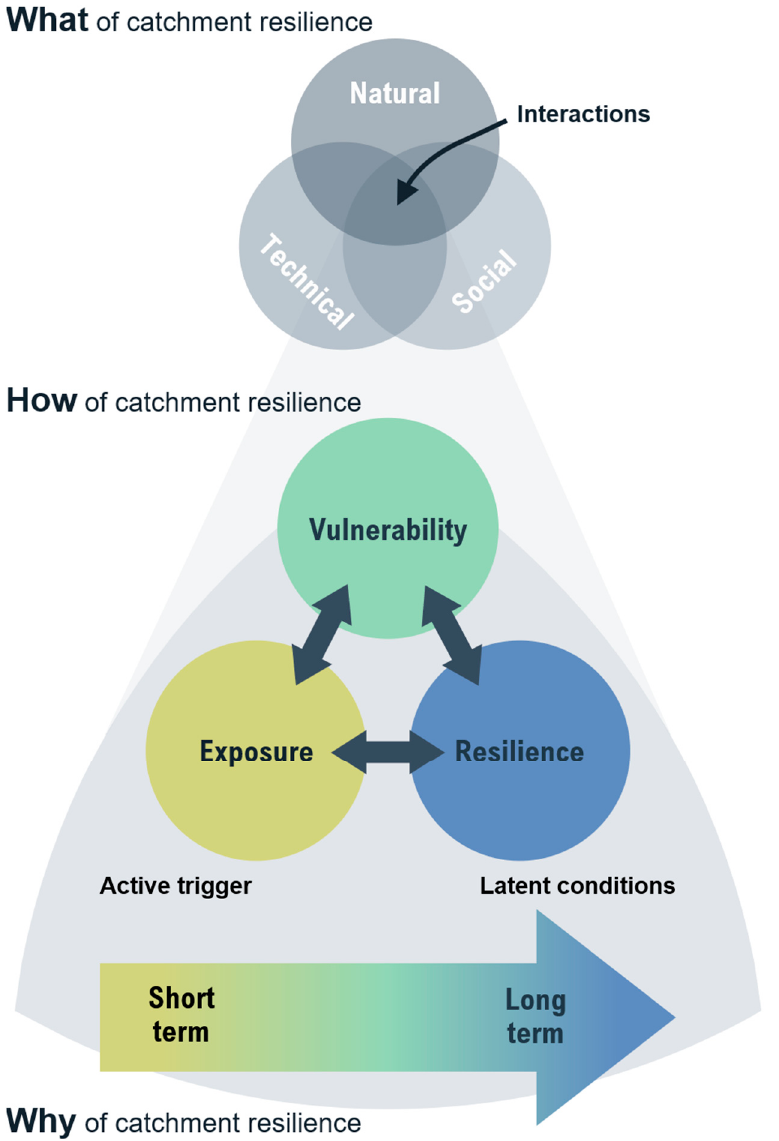
Figure 2. Conceptual framework for utilising catchment resilience as a unifying concept in hydrohazard management.